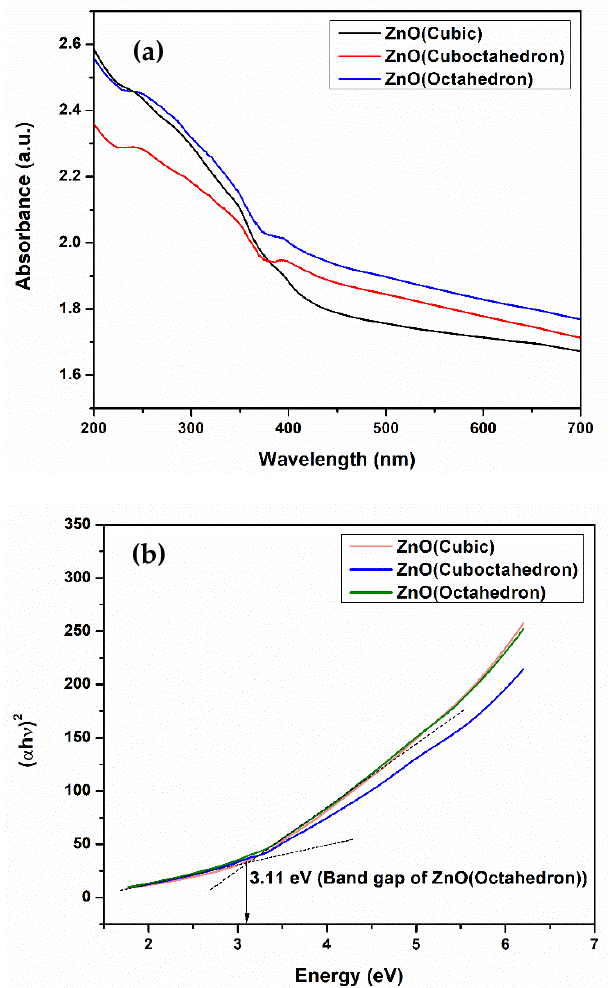
Figure 17. Spectra and estimated optical absorption band gap of the synthesized ZnO. ( a ) UV-visible absorption spectra of synthesized ZnO and ( b ) Kubelka–Munk-transformed reflectance.